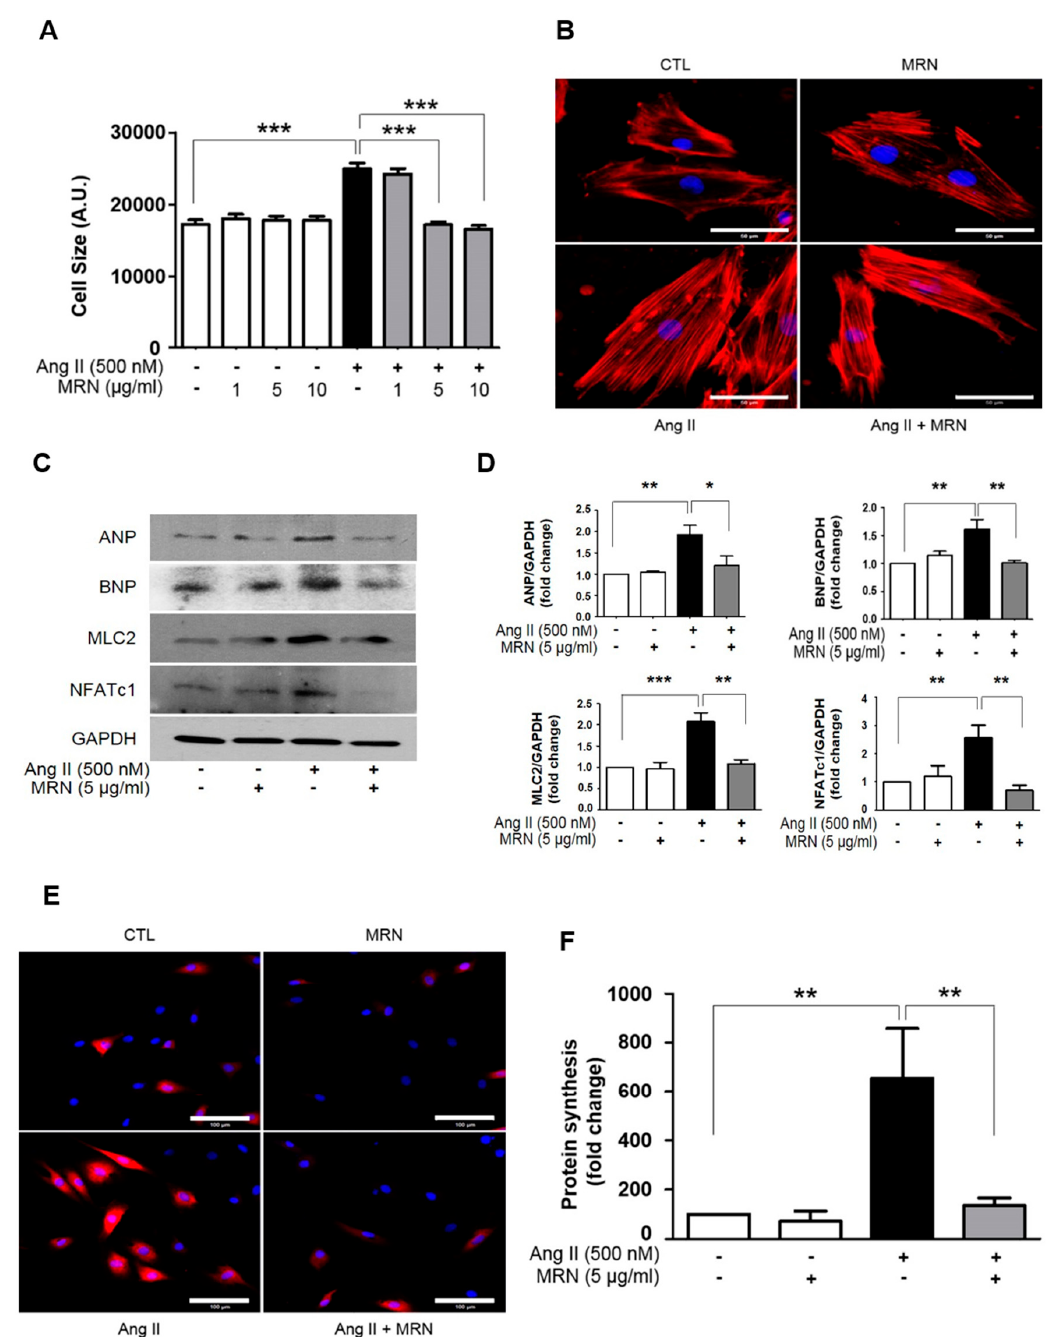
Figure 2. Nelumbo nucifera receptaculum extract (MRN) reduces Ang II-induced cardiomyocyte hypertrophy. H9c2 cells were treated with 500 nM Ang II for 48 h in the presence or absence of 5 µ g / mL MRN. ( A ) Cell size was measured from 50–150 cells in each group and analyzed using ImageJ software. Results are representative of three separate experiments. *** p < 0.001. ( B ) F-actin in H9c2 cells was stained with Texas Red-X phalloidin and detected using confocal microscopy. Scale bar = 50 µ m. ( C,D ) Western blot of expression of cardiomyocyte hypertrophic markers (ANP, BNP, NFATc1, MLC2v) and GAPDH. Results are representative of five separate experiments. * p < 0.05, ** p < 0.01, *** p < 0.001. ( E,F ) Protein synthesis was detected using a Click-iT HPG Alexa Fluor protein synthesis assay system. Scale bar = 100 µ m. Results are representative of three separate experiments. ** p < 0.01. The bars represent the mean ±